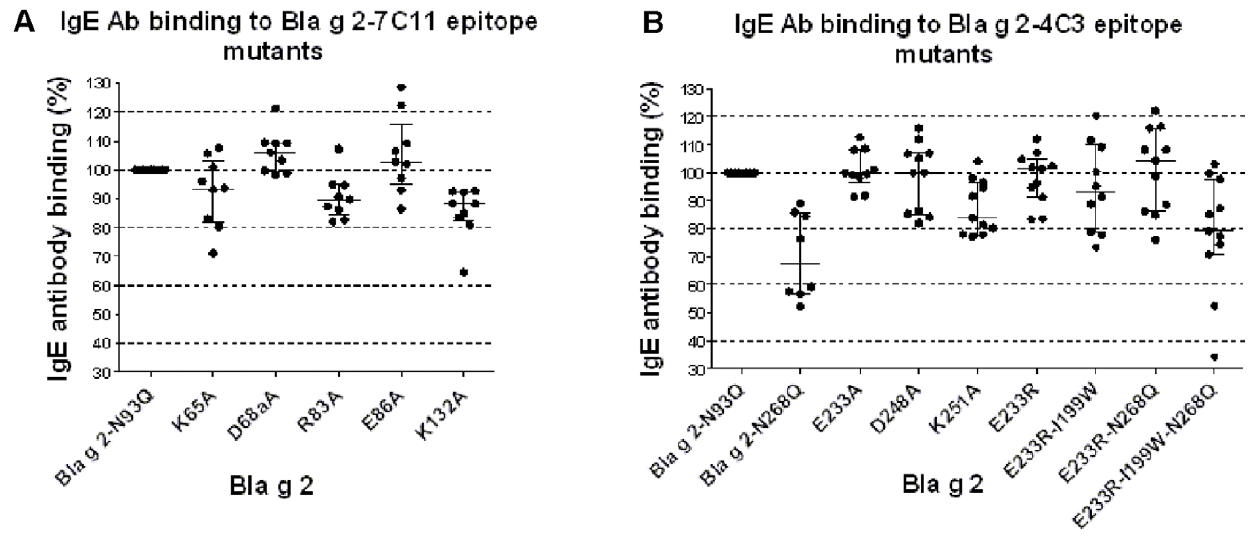
Figure 8. Binding of IgE antibodies from cockroach allergic patients to rBla g 2-N93Q and epitope mutants. A) IgE binding to mAb 7C11 epitope mutants, and B) IgE binding to mAb 4C3 epitope mutants. In A and B scatter plots show median of percentages ( 6 interquartile ranges) of IgE binding versus rBla g 2-N93Q for the sera tested (n=8–11) Each data point was calculated as average of percentage of IgE binding ( 6 SEM) versus the rBla g 2-N93Q for 1–4 tests per serum depending on serum availability.